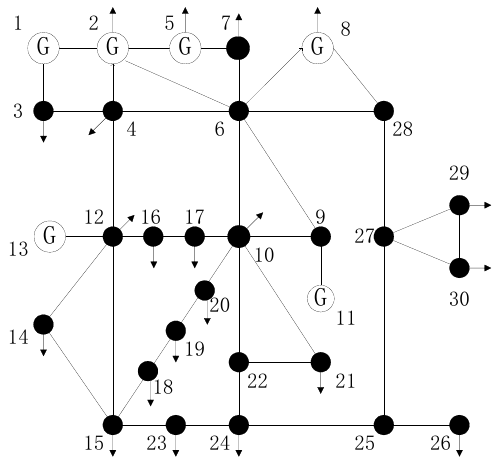
Figure 1. Model of the IEEE 30-bus test system.